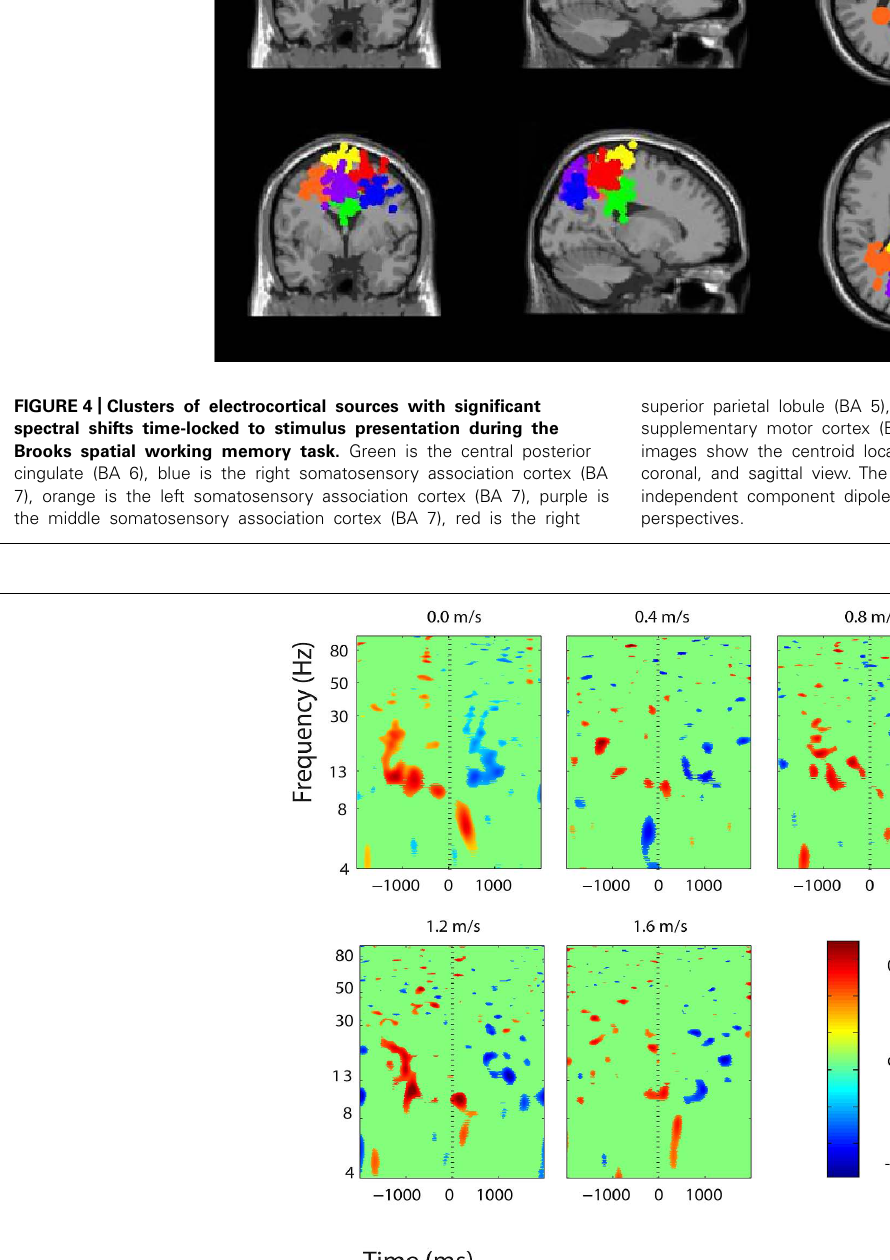
FIGURE 5 | Event-related spectral perturbation (ERSP) plots showing power change around the presentation of a stimulus (a digit and its position in an imagined grid) in the left somatosensory association cortex (BA 7). Red represents a power increase from